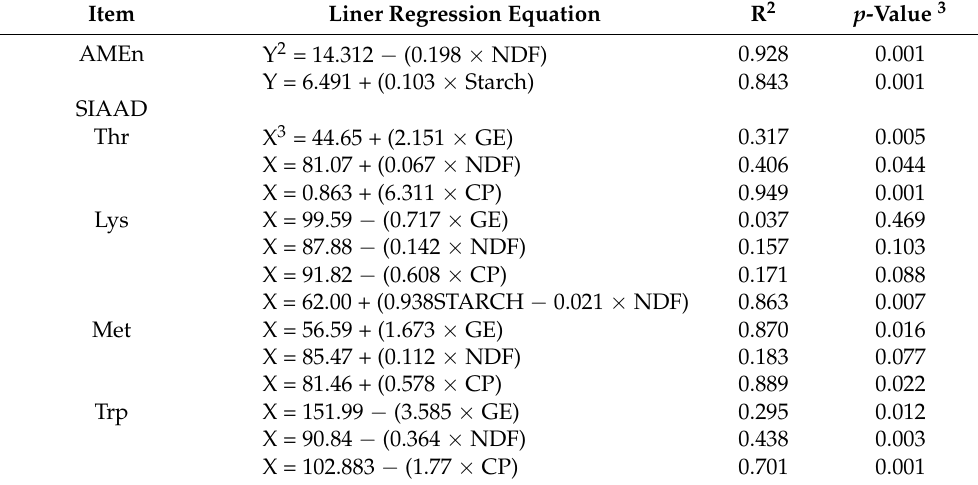
Table 11. The linear regression equation of AMEn and SIAAD of selected amino acids. Item Liner Regression